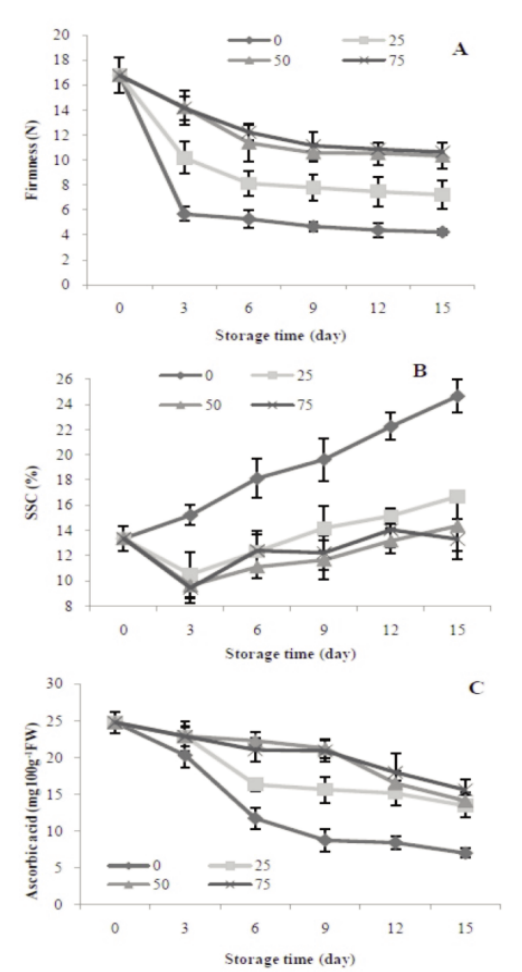
Fig. 1 ­ Firmness (A), soluble solid concentration (SSC) (B) and ascorbic acid content (C) values in figs ( Ficus carica L.) ‘Siyah’ fruit treated with Aloe vera gel (0, 25, 50 and 75%). Fruit were stored at 2°C. Vertical bars represent standard error of means of three experiments with four replicates per